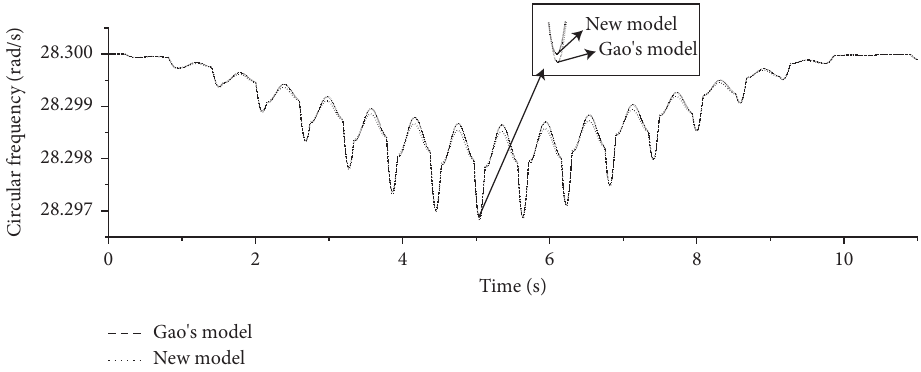
Figure 10: Frequency of the system (initial vector optimized).